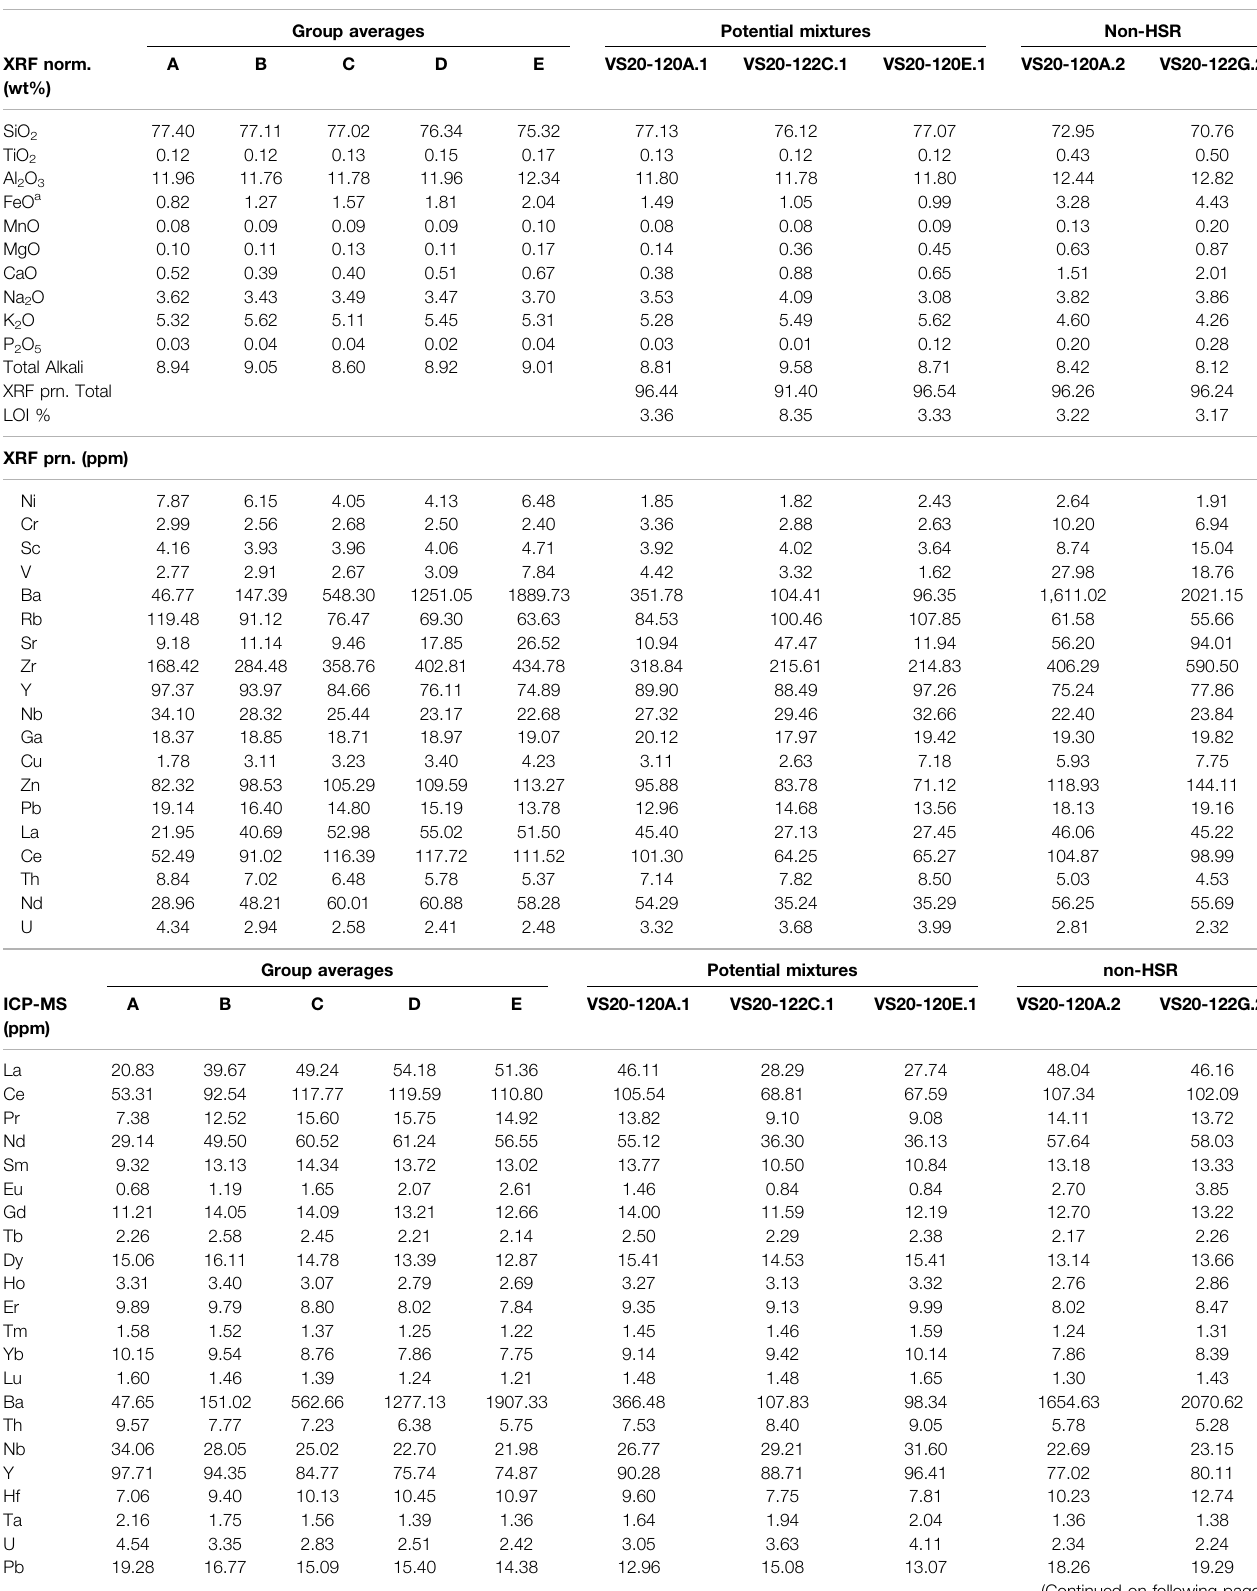
TABLE 2 | Average geochemical compositions for Rattlesnake Tuff high-silica rhyolite Groups. Group averages Potential mixtures Non-HSR XRF norm.